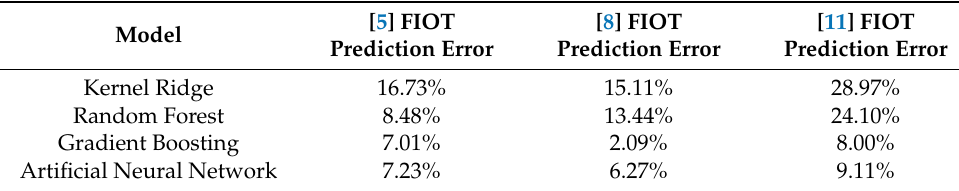
Table 7. Machine learning models accuracy for the literature experimental